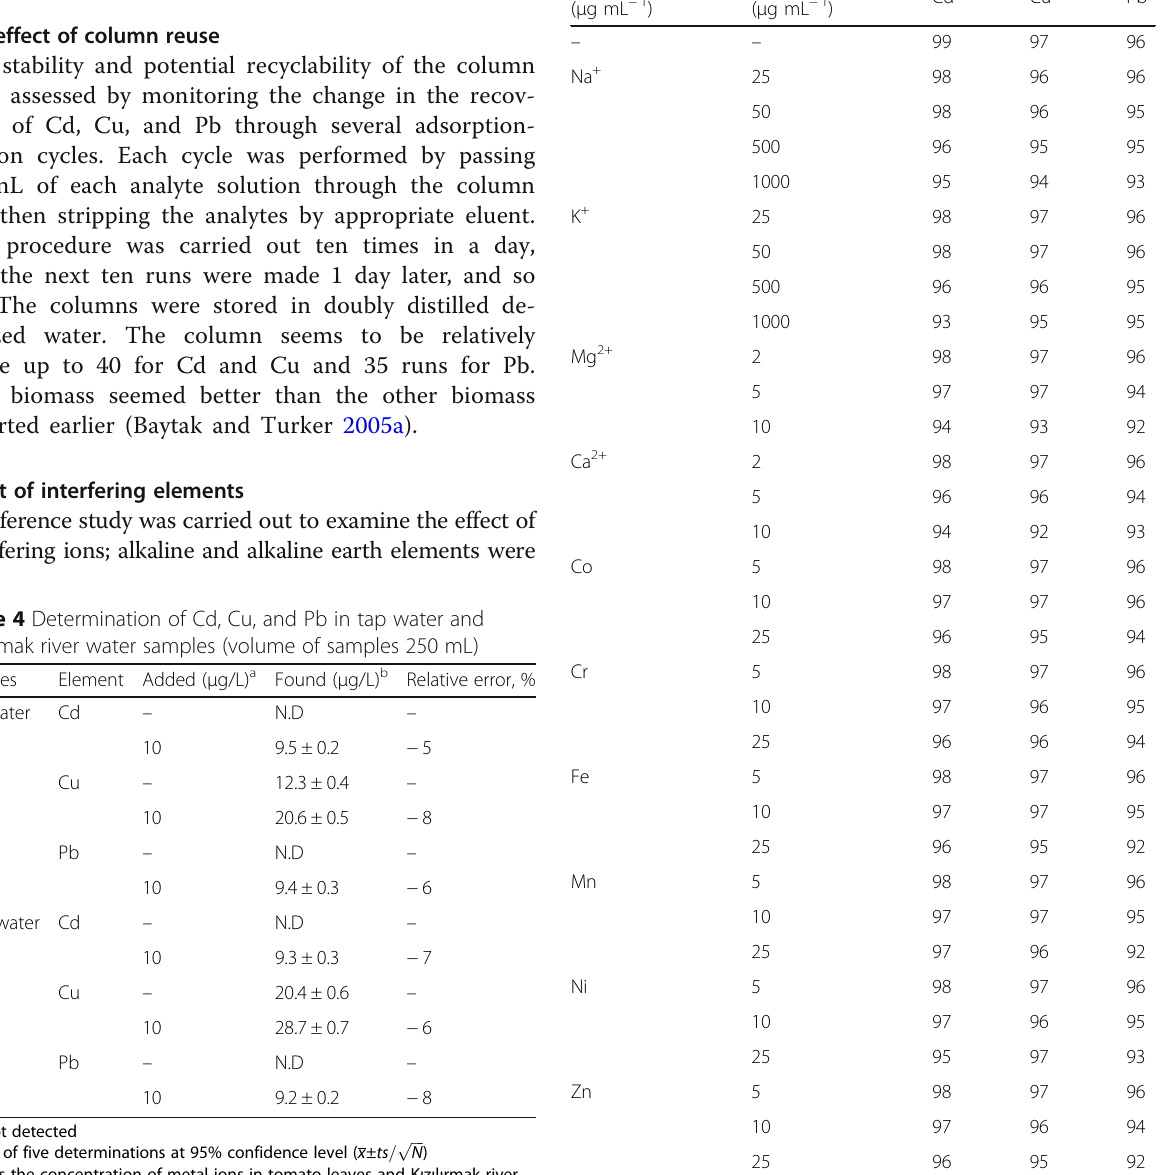
added to the synthetic samples containing Cd, Cu, and Pb. Nitrate or chloride salts of interfering elements were added to the sample solutions. The concentration of ana- lytes was kept constant, and the concentration of interfer- ing ions was used in the range of 2 – 1000 μ g mL − 1 . It can be seen in the Table 5 that there is no significant effect of interfering ions on the recovery of analytes.